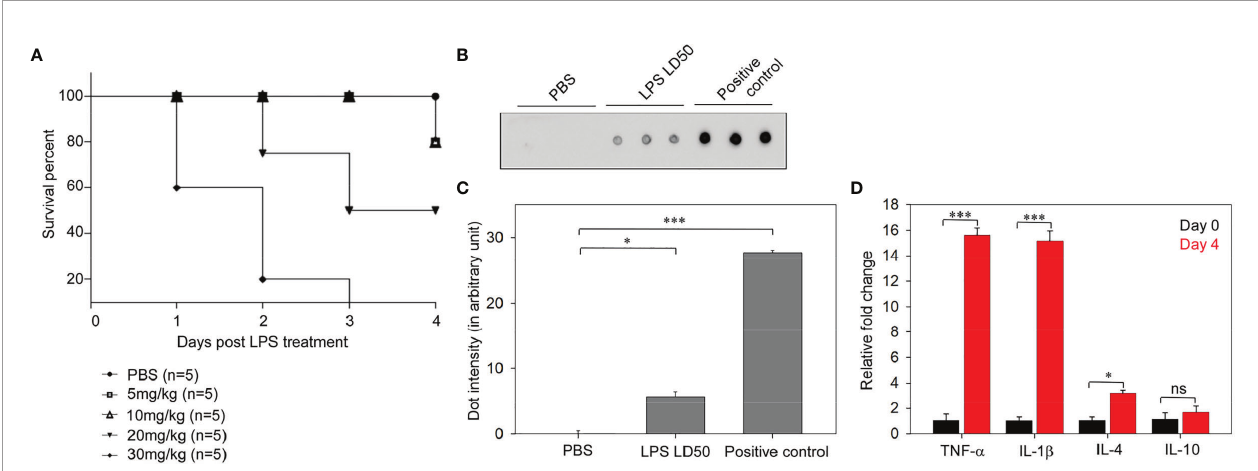
FIGURE 2 | Determination of lipopolysaccharide (LPS) median lethal dose (LD 50 ) of Leptospira interrogans serovar Autumnalis strain N2 in BALB/c mice. (A) Representative Kaplan – Meier plot of LD 50 determinations showing the survivability at different doses (5, 10, 20, and 30 mg/kg) of leptospiral LPS-injected mice. (B) Dot blot assay of the LD 50 (10 mg/kg) of leptospiral LPS causing endotoxemia in infected mice. Plasma samples of mice injected with PBS and LD 50 LPS were assayed. Puri fi ed LPS was loaded as a positive control. (C) Representative graph of the dot intensity of samples. (D) Analysis of the expressions of in fl ammatory cytokines in the leptospiral LPS-injected mouse model by qRT-PCR. n = 3 experiments. * p < 0.05; *** p < 0.001, ns, no signi fi